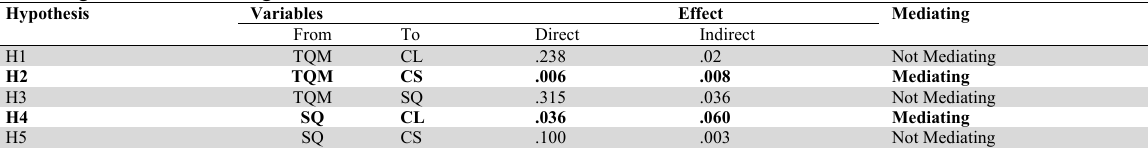
Mediating and non-mediating effects Hypothesis